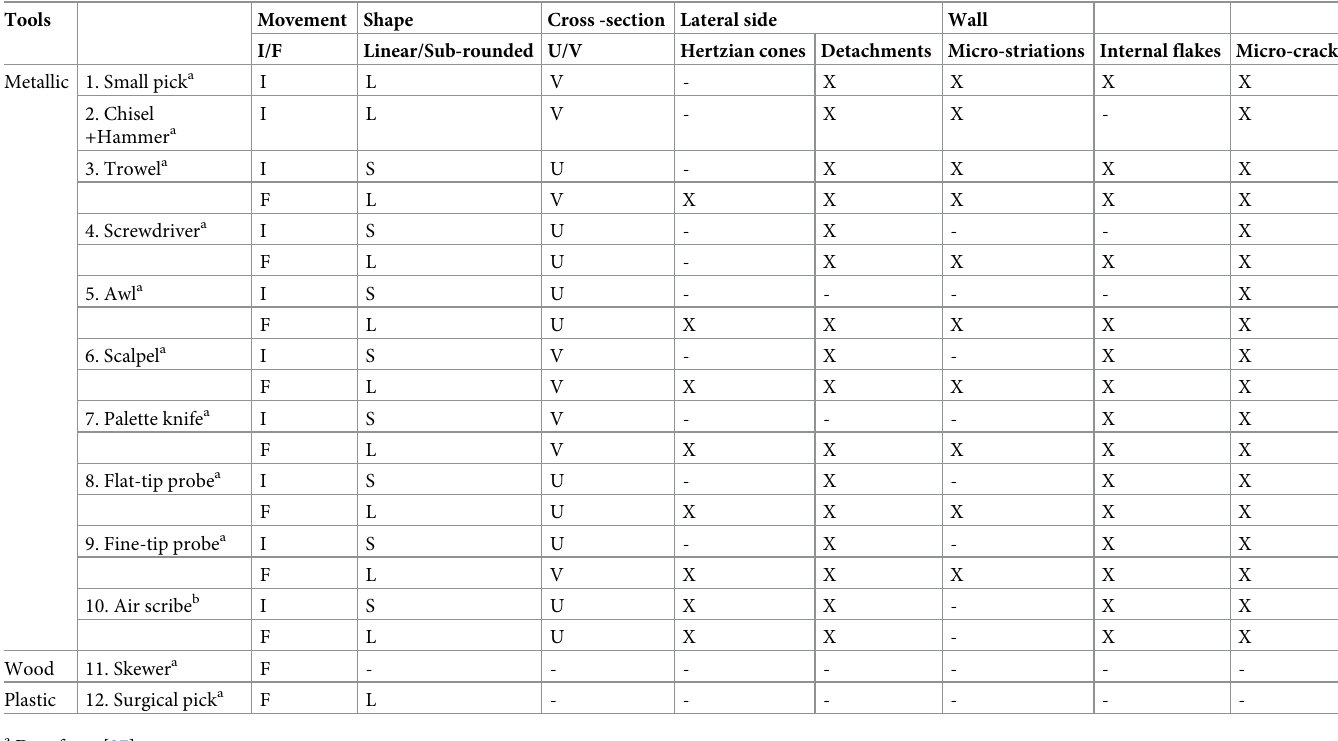
Table 1. Characteristics of bone damage produced by various tools; adapted from [27]. I = Impact; F = Friction; L = Linear; S = Sub-rounded; X = present; - = absent.